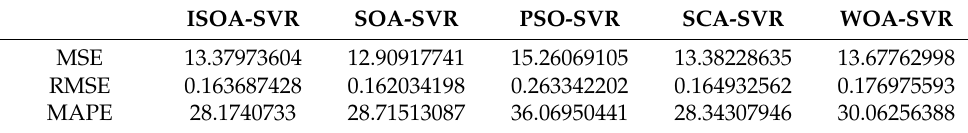
Figure 7. Fitness convergence curves of five algorithms in Experiment 2. Table 10. The MSE, RMSE and MAPE index results of five models in Experiment 2.